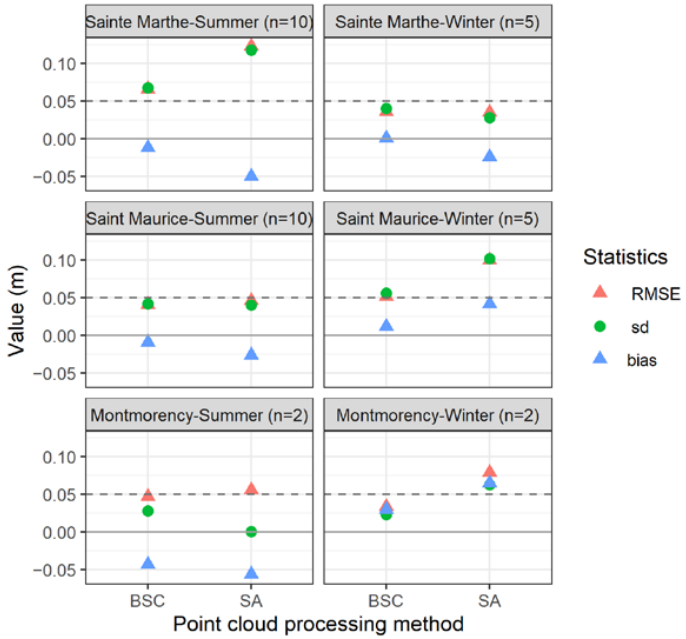
Figure 7. Absolute error statistics of lidar point clouds. Plots are segmented by site (rows), data processing method (columns), and error statistics (colors). The grey dashed line is the expected accuracy of the lidar system. n denotes the number of GCPs. BSC: Boresight calibrated point cloud; SA: Boresight + strip-aligned point cloud. (Bias was calculated as lidar-derived DEM elevation − GNSS elevation at GCPs).